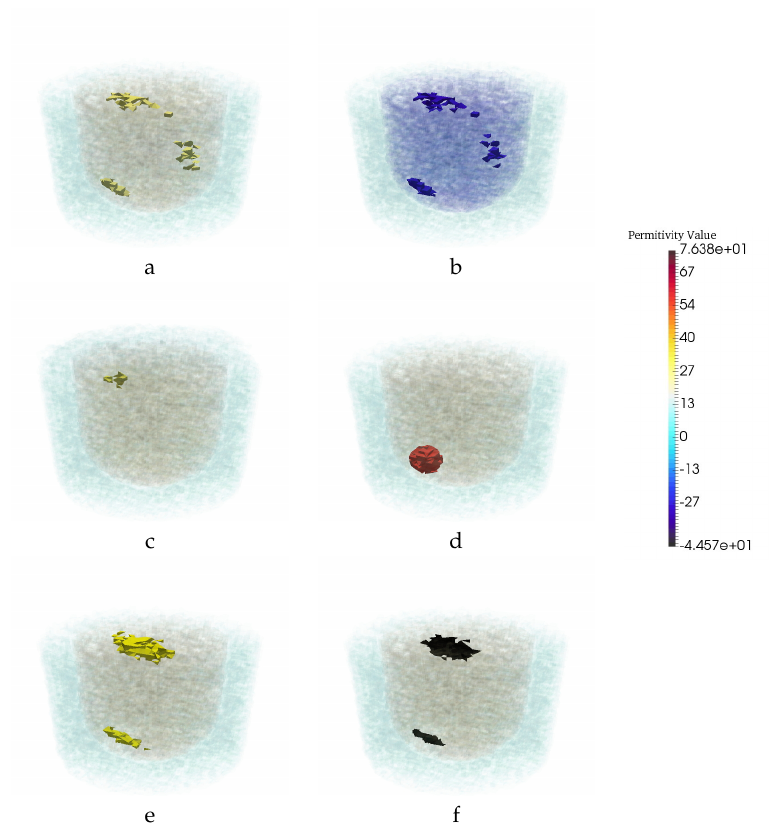
Figure 13. Reconstruction results for a particular example when the test images are CSI results in high frequencies but the neural net was trained on low frequencies. The real ( a ) and imaginary ( b ) part of CSI reconstruction. ( c ) CNN reconstruction. ( d ) Ground truth. ( e ) Intersection of real part of CSI reconstruction at all frequencies.( f ) Intersection of imaginary part of CSI reconstruction at all frequencies(two intersection images are binary